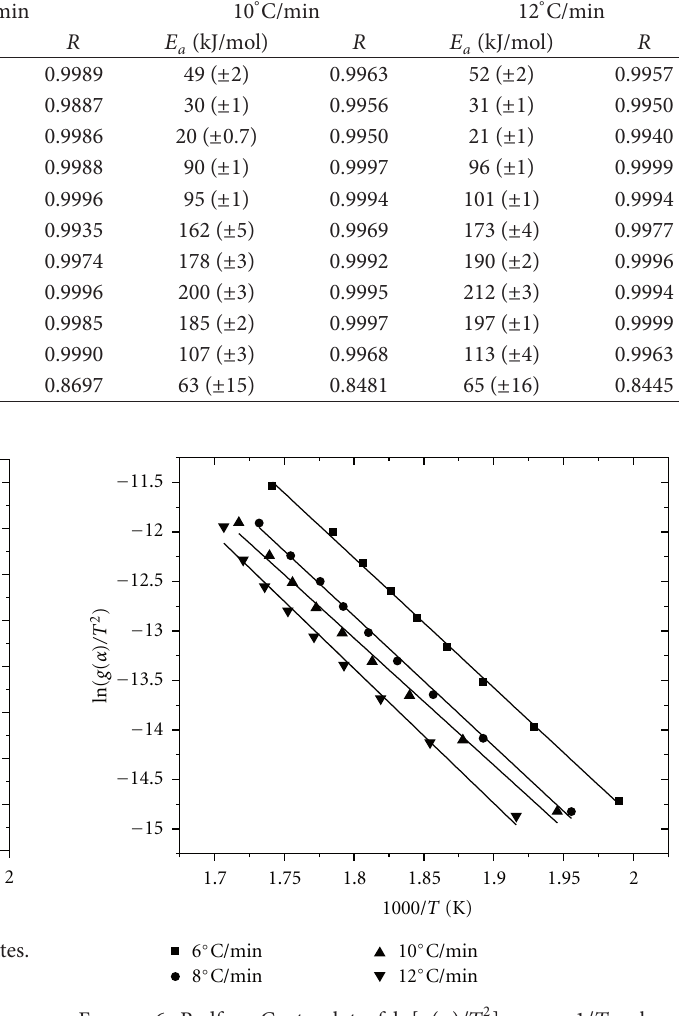
F 6: Redfern-Coats plot